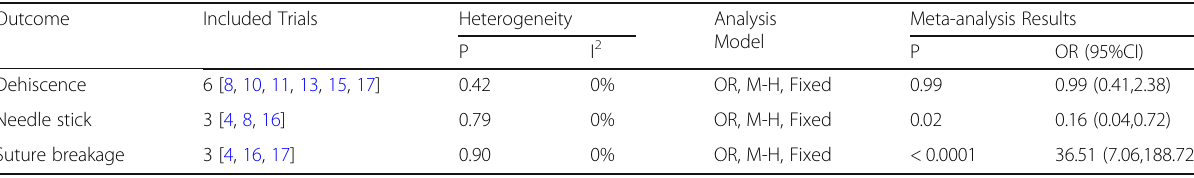
Table 3 Meta-analysis Results for Other Outcome Measures Outcome Included Trials